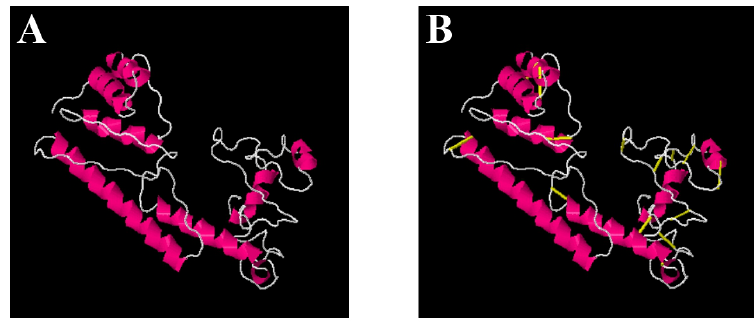
Table 5. Amino acid residues that are replaced by cysteine amino acid. Figure 7. ( A ) Original structure of vaccine molecule. ( B ) Mutated structure.